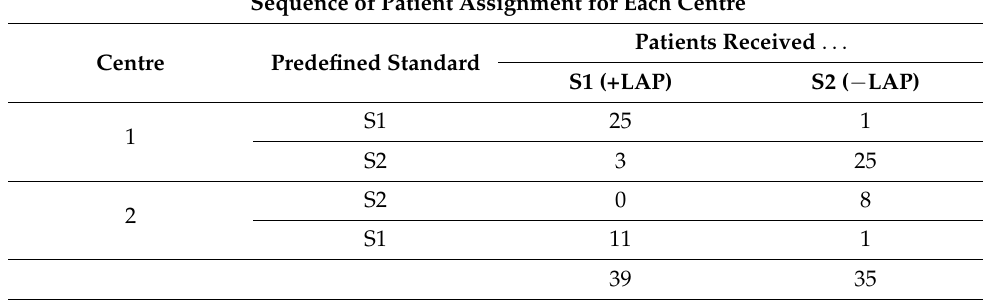
Table A1. Sequence of patient assignment. S1—Standard 1 with LAP, S2—Standard 2 without LAP; LAP—local anaesthesia of the pharynx.